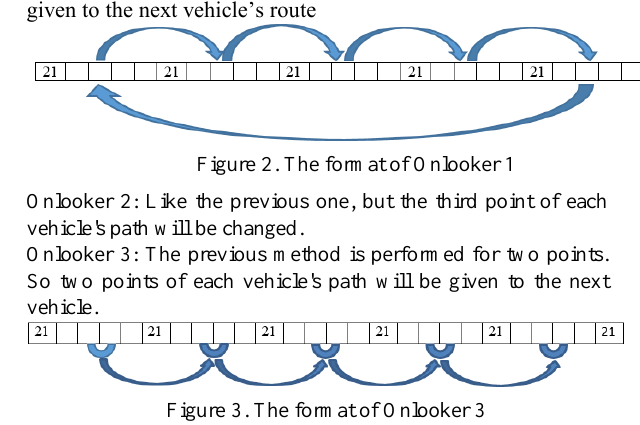
Figure 3. The format of Onlooker